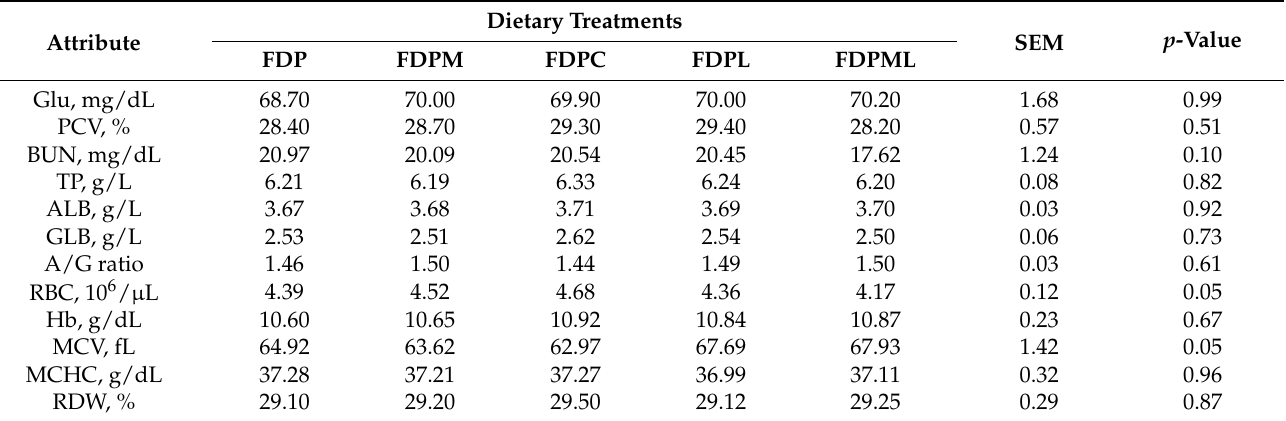
Table 6. Effects of untreated and treated discarded durian peel in TMR on blood metabolites in growing